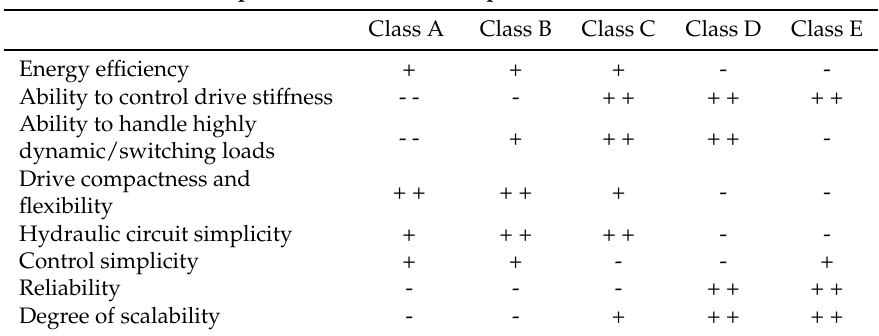
Table 1. The derived drive classes are assessed based on eight criteria. Four different grades are used, ranging from (- -) to (+ +), with (- -) being the worst. Comparison between the Proposed Drive Classes Class A Class B Class C Class D Class E Energy efficiency + + + - - Ability to control drive stiffness - - - + + + + + + Ability to handle highly - - + + + + + - dynamic/switching loads Drive compactness and + + + + + - - flexibility Hydraulic circuit simplicity + + + + + - - Control simplicity + + - - + Reliability - - - + + + + Degree of scalability - - + + + +